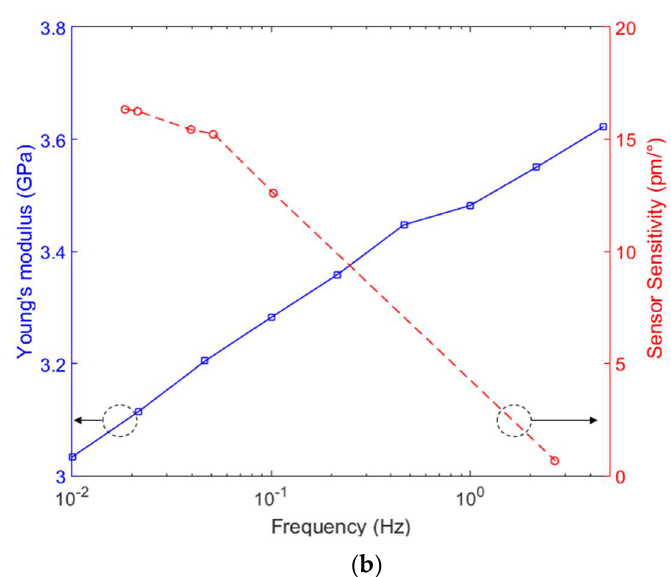
Figure 7. ( a ) POFBG curvature sensor response for three different frequencies (0.50, 1.32 and 4.49 Hz). ( b ) Comparison between the sensor sensitivity and Young’s modulus variations with respect to frequency.